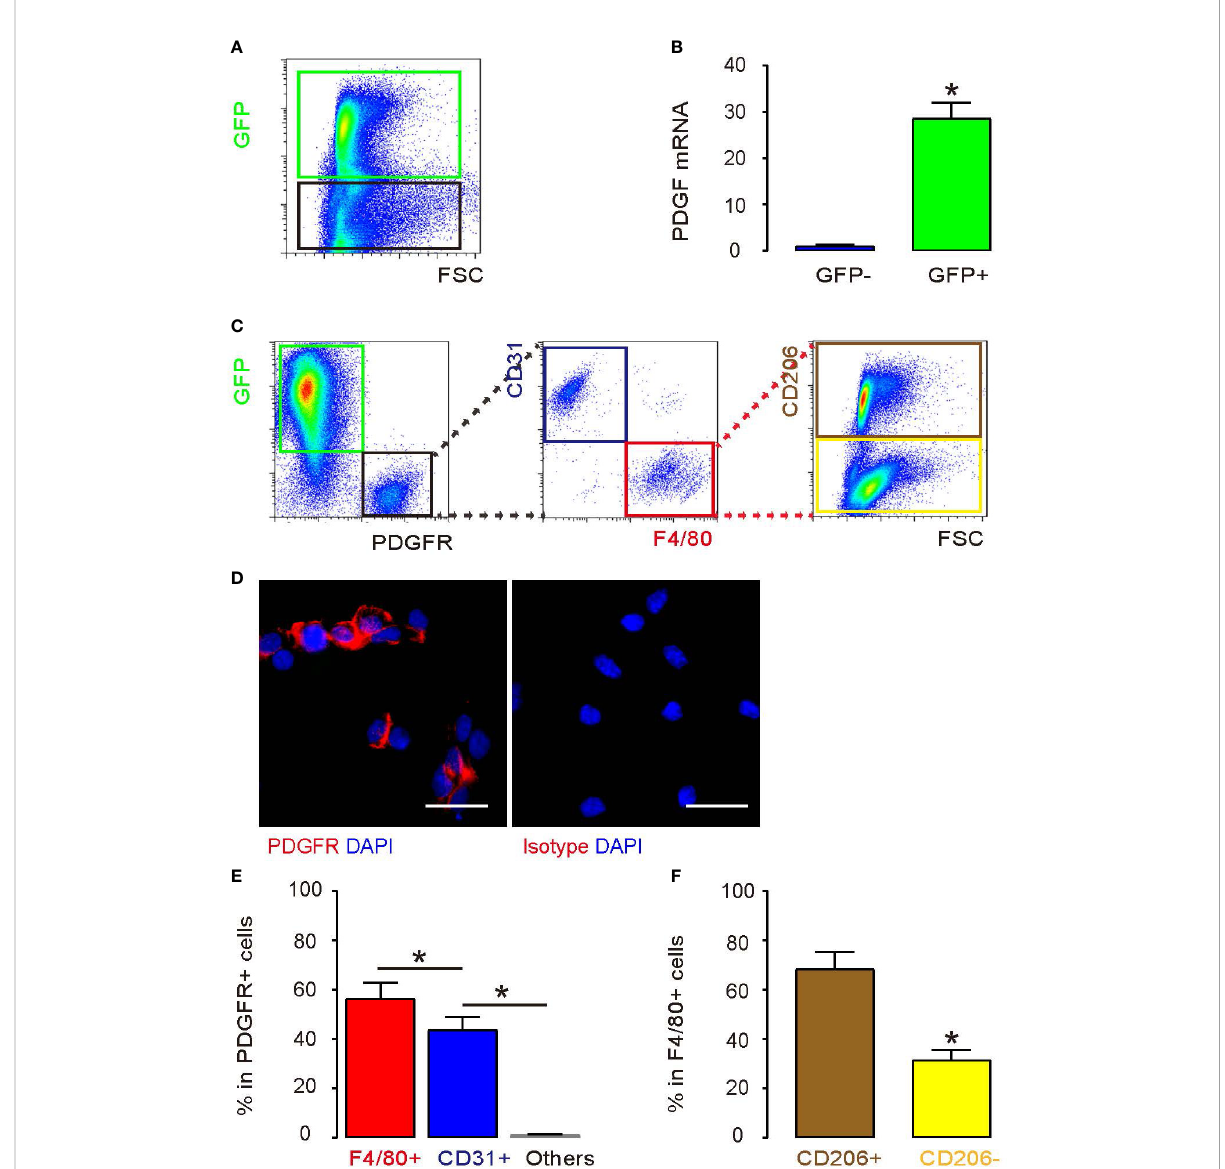
FIGURE 3 PrC cells express a high level of PDGF and TAMs express a high level of PDGFR (A) PrC cells from the mice model were detected by green fl uorescence. (B) PDGF mRNA level of GFP-positive cells vs. GFP-negative cells. (C) Analyses of GFP-positive cells and PDGFR-positive cells from the PrC mouse model. PDGFR+ cells were divided into two populations based on CD31 and F4/80 expression. PDGFR+ F4/80+ cells were further analyzed for CD206 expression. The gating strategy for the fl ow cytometry was shown. (D) Staining with a PDGFR antibody or isotype control on green cells. (E) % of F4/80+, CD31+, and other cells in PDGFR+ cells measured by fl ow cytometry. (F) % of CD206+, CD206- cells in PDGFR+F4/80+ cells. * p < 0.05. n = 5. Scale bars are 20